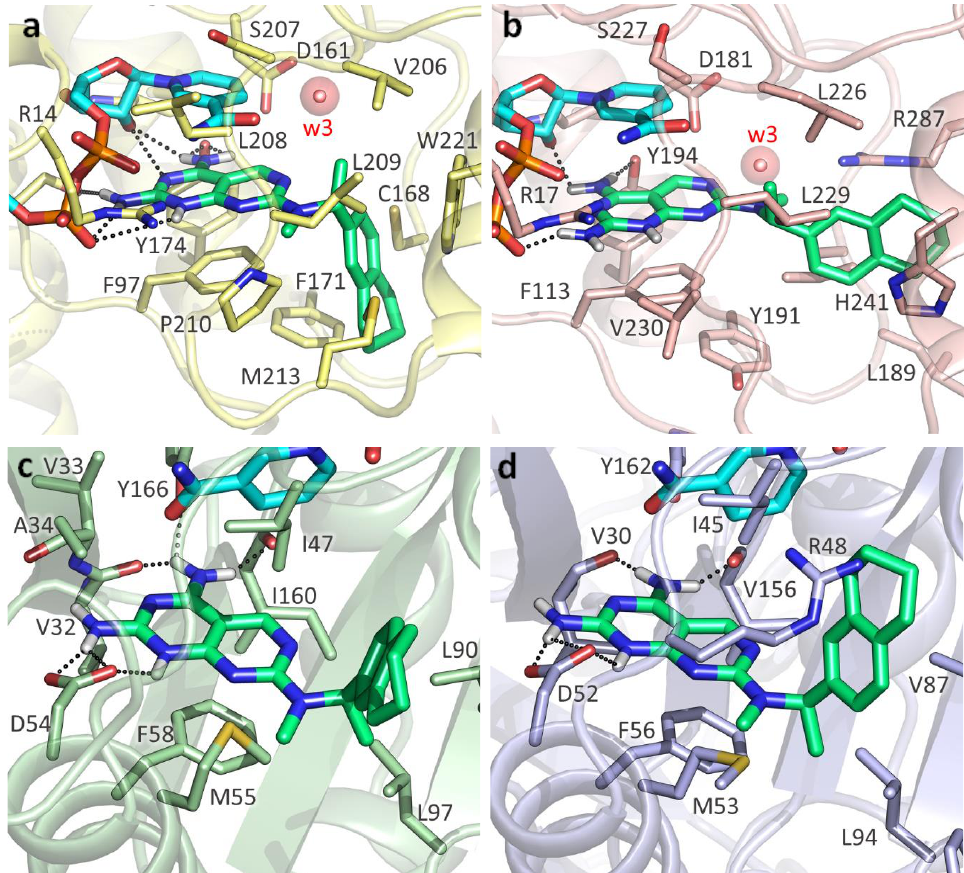
Figure 4. TCMDC-143296 docking poses in the different reductases. ( a ) TCMDC-143296 in Tb PTR1 (PDB ID:2C7V). ( b ) TCMDC-143296 in Lm PTR1 (PDB ID:2BFA). ( c ) TCMDC-143296 in Tb DHFR (PDB ID:3RG9). ( d ) TCMDC-143296 in Lm DHFR-TS (model). Protein is represented as cartoon ( Tb PTR1, light yellow; Lm PTR1, light pink; Tb DHFR, light green; Lm DHFR-TS, light blue). TCMDC-143296 (green), NADPH cofactor (cyan) and binding site residues are depicted as sticks and labelled. Hydrogen bonds are indicated as black dashed lines. Water molecules, indicated when not displaced by the docking, are reported as red spheres with their Van der Waals radius visible in transparency.